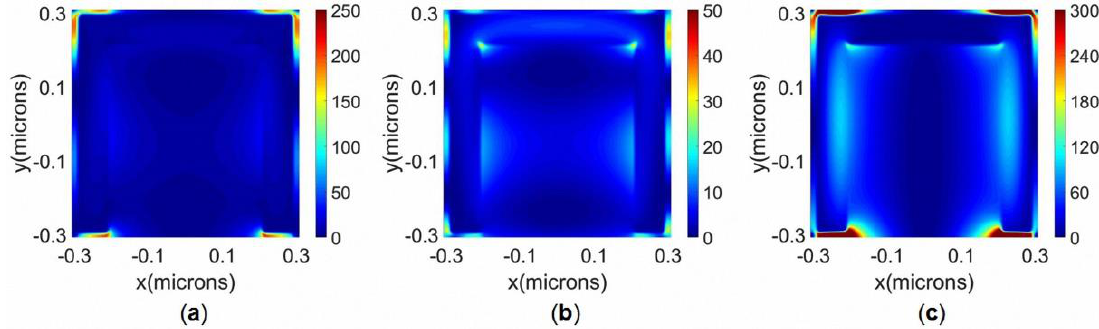
Figure 2. Electric field distributions of the dielectric metamaterial at different wavelengths. ( a ), ( b ) and ( c ) correspond to the wavelengths of 898.5 nm, 928 nm and 908.5 nm, respectively. The other geometrical parameters are the same as in Figure 1b.